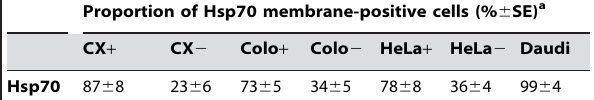
Table 1. Flow cytometric analysis of viable, 7-AAD- and Annexin-V-negative CX + /CX 2 , Colo + /Colo 2 and HeLa + / HeLa 2 (HeLa Bag-4/HeLa neo) carcinoma sublines and Daudi Burkitt’s lymphoma cells.